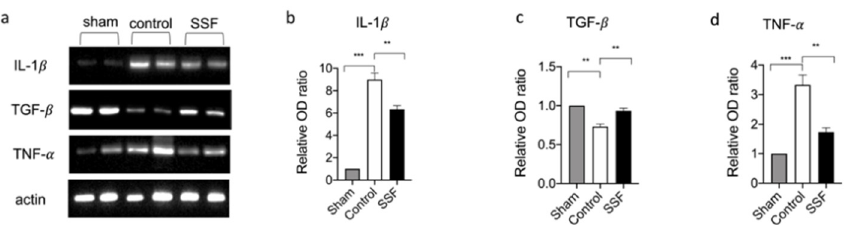
Figure 6. ( a ) Western blot analysis on wound tissue for. ( b ) IL-1 β . ( c ) TGF- β , and ( d ) TNF- α , and relative densitometric analysis. Data are presented as means ± SEM images of 10 mice for each group. ** p < 0.01; *** p < 0.001.